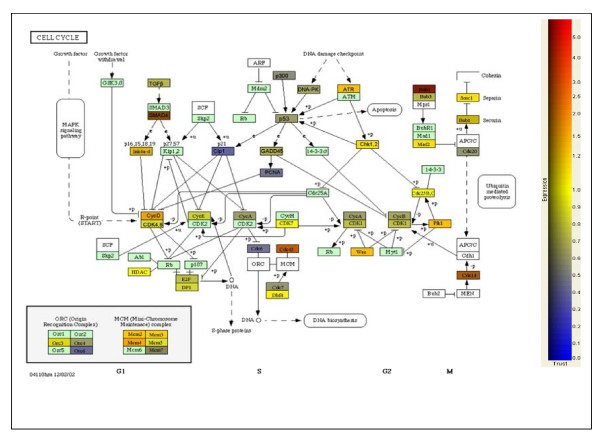
Real time pathway analysis of cell-cycle related genes mediated via TS overexpression in HCT-C18 (TS+) cells using actual gene expression data. (Red color indicates overexpression. Blue color indicates decreased expression).